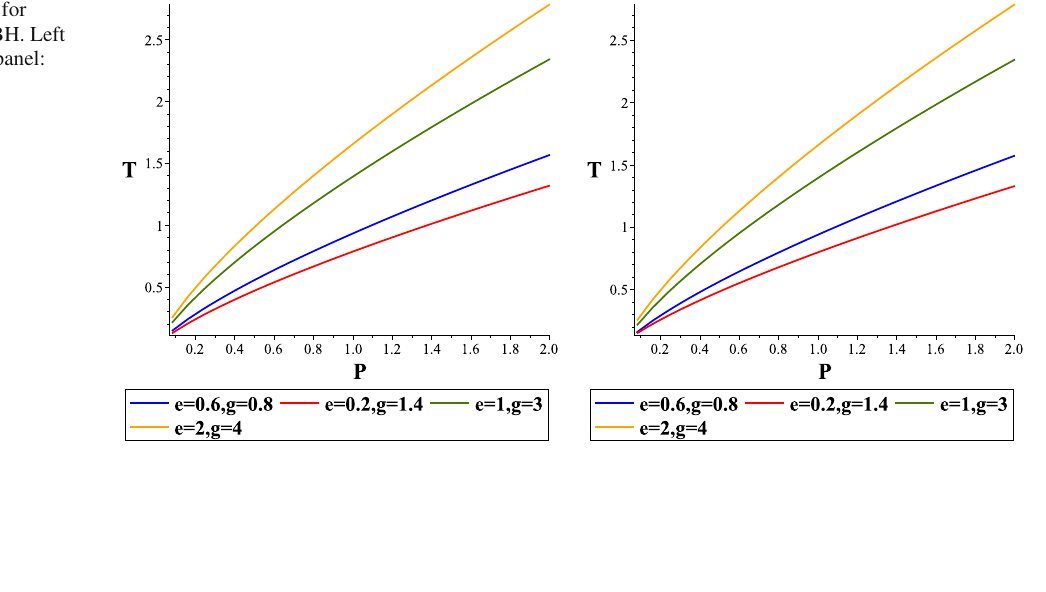
Fig. 5 Inversion and isenthalpic curves for dynamic phantom AdS BH for a 2 =